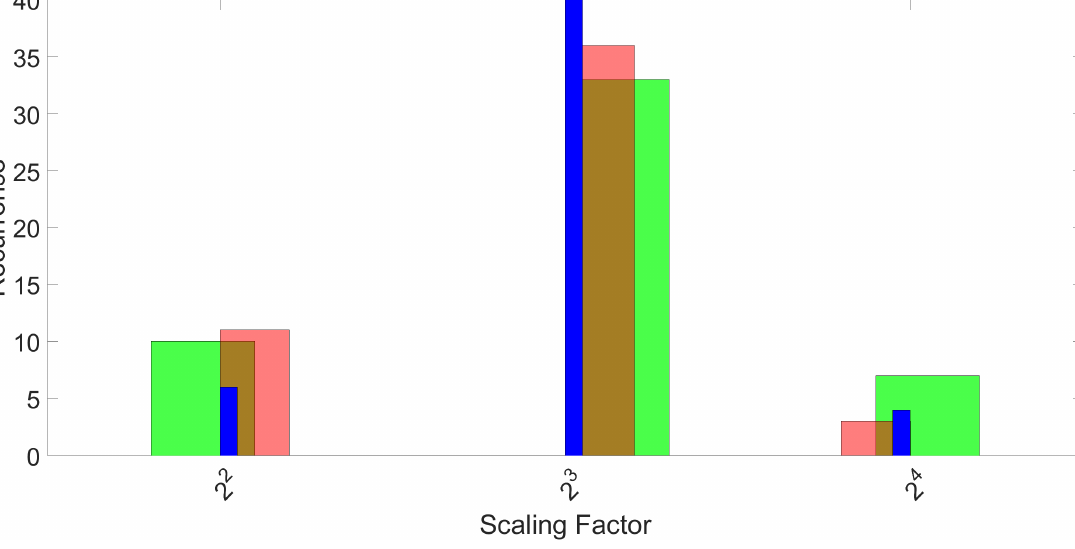
Figure 7. Histograms of the recurrence of the best performing scaling factor γ for 50 repetitions and three folds. The three colors represent the three